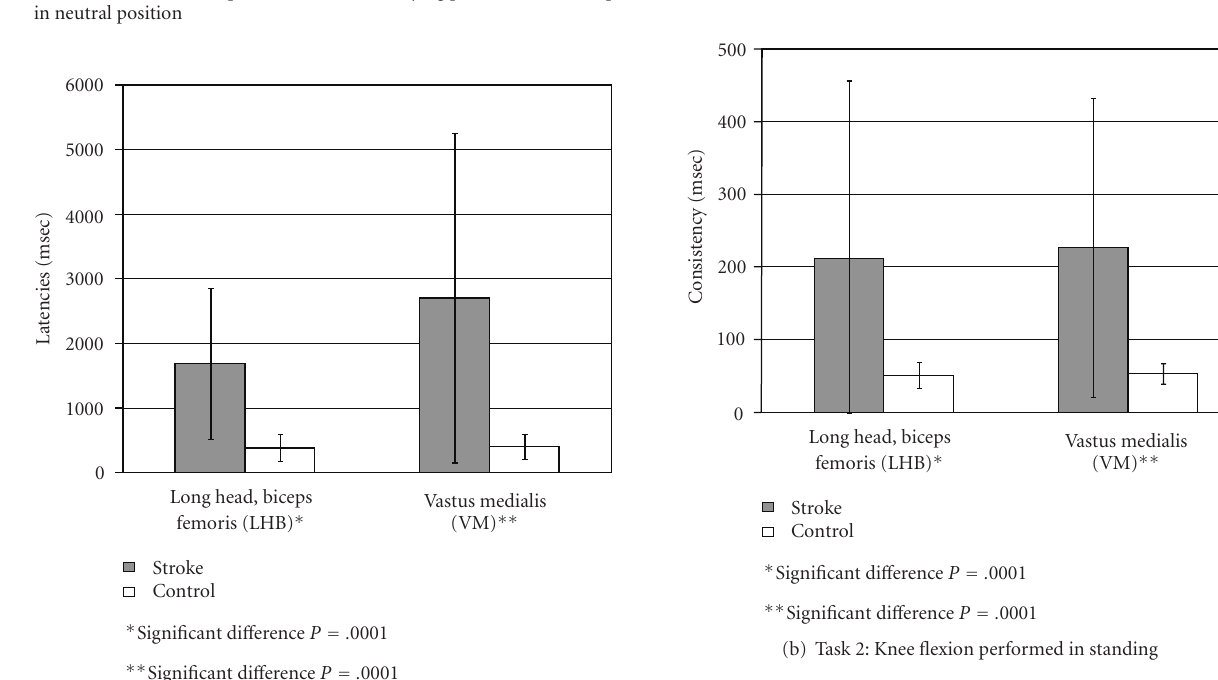
Figure 4: Comparison of consistency for control and stroke